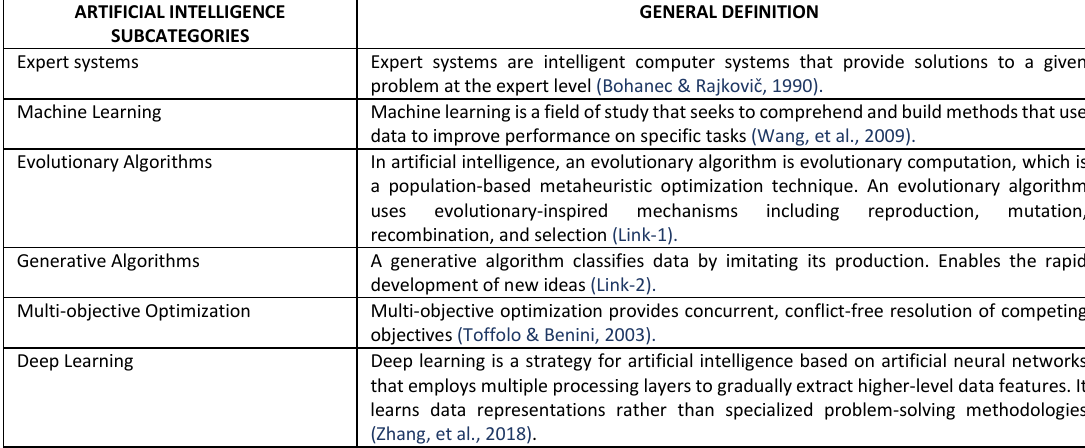
Table 2 Definitions of concepts in the literature related to artificial intelligence subcategories, definitions and